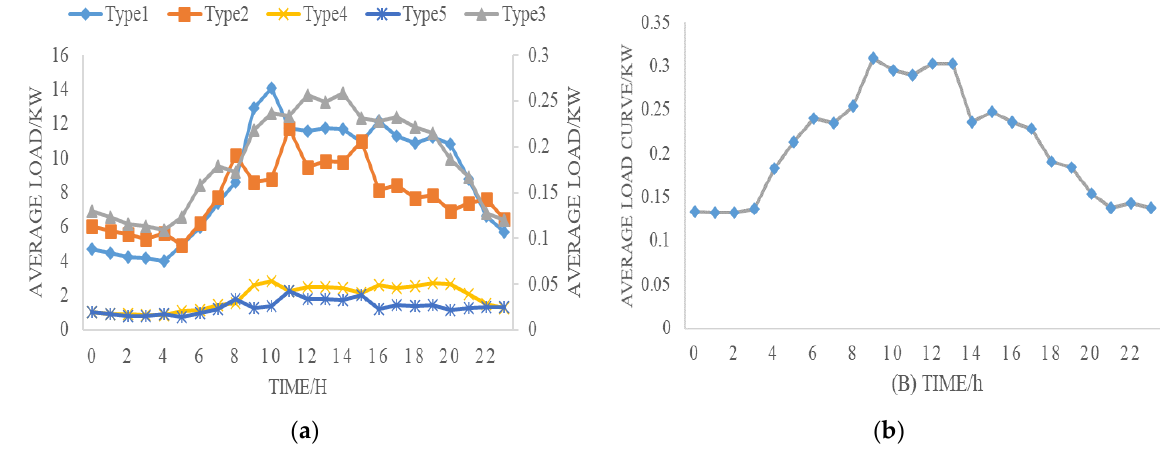
Figure 8. The load curve in November ( a ) clustered 5 types of loads; ( b ) the type 3 load.